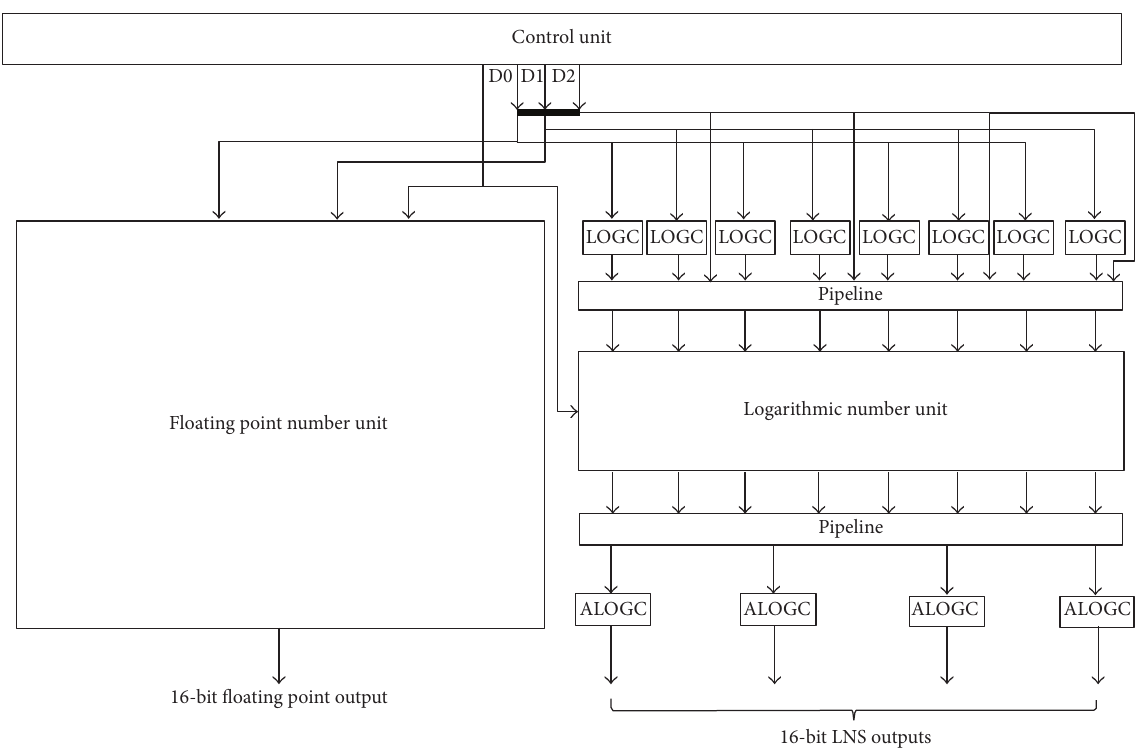
Figure 1: Architecture of special function unit.